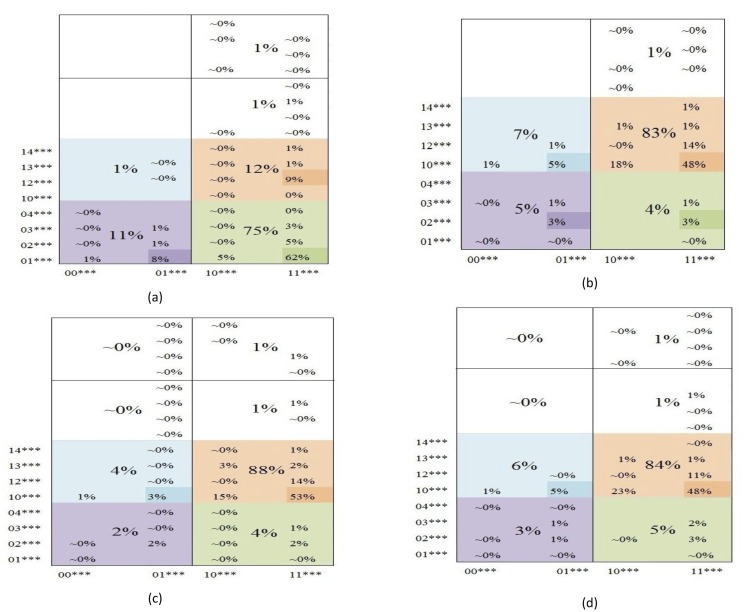
Percentage of visits of (a) SA Rich, (b) SA Poor, (c) MOZ Rich, and (d) MOZ Poor household orbits to regions in S
5 determined by the first and second significant variables.